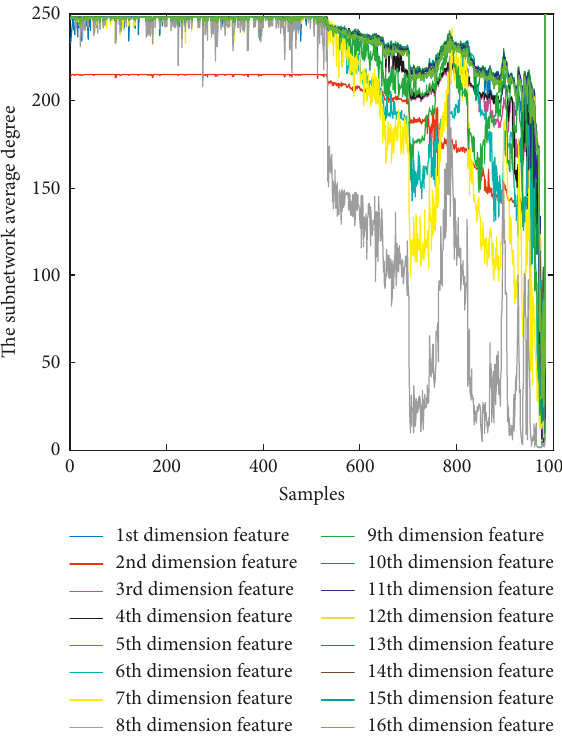
Figure 18: Subnetwork average degree of bearing all